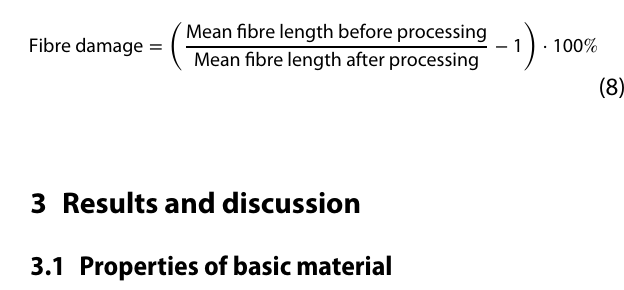
*Calculated for its condition in yarn with a mean fibre length of